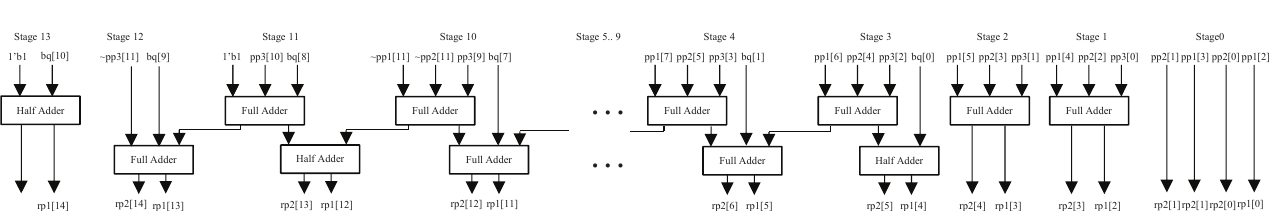
Figure 11. Compressor circuit used in the implementations of 1 rp2 are the two results of the compressor.